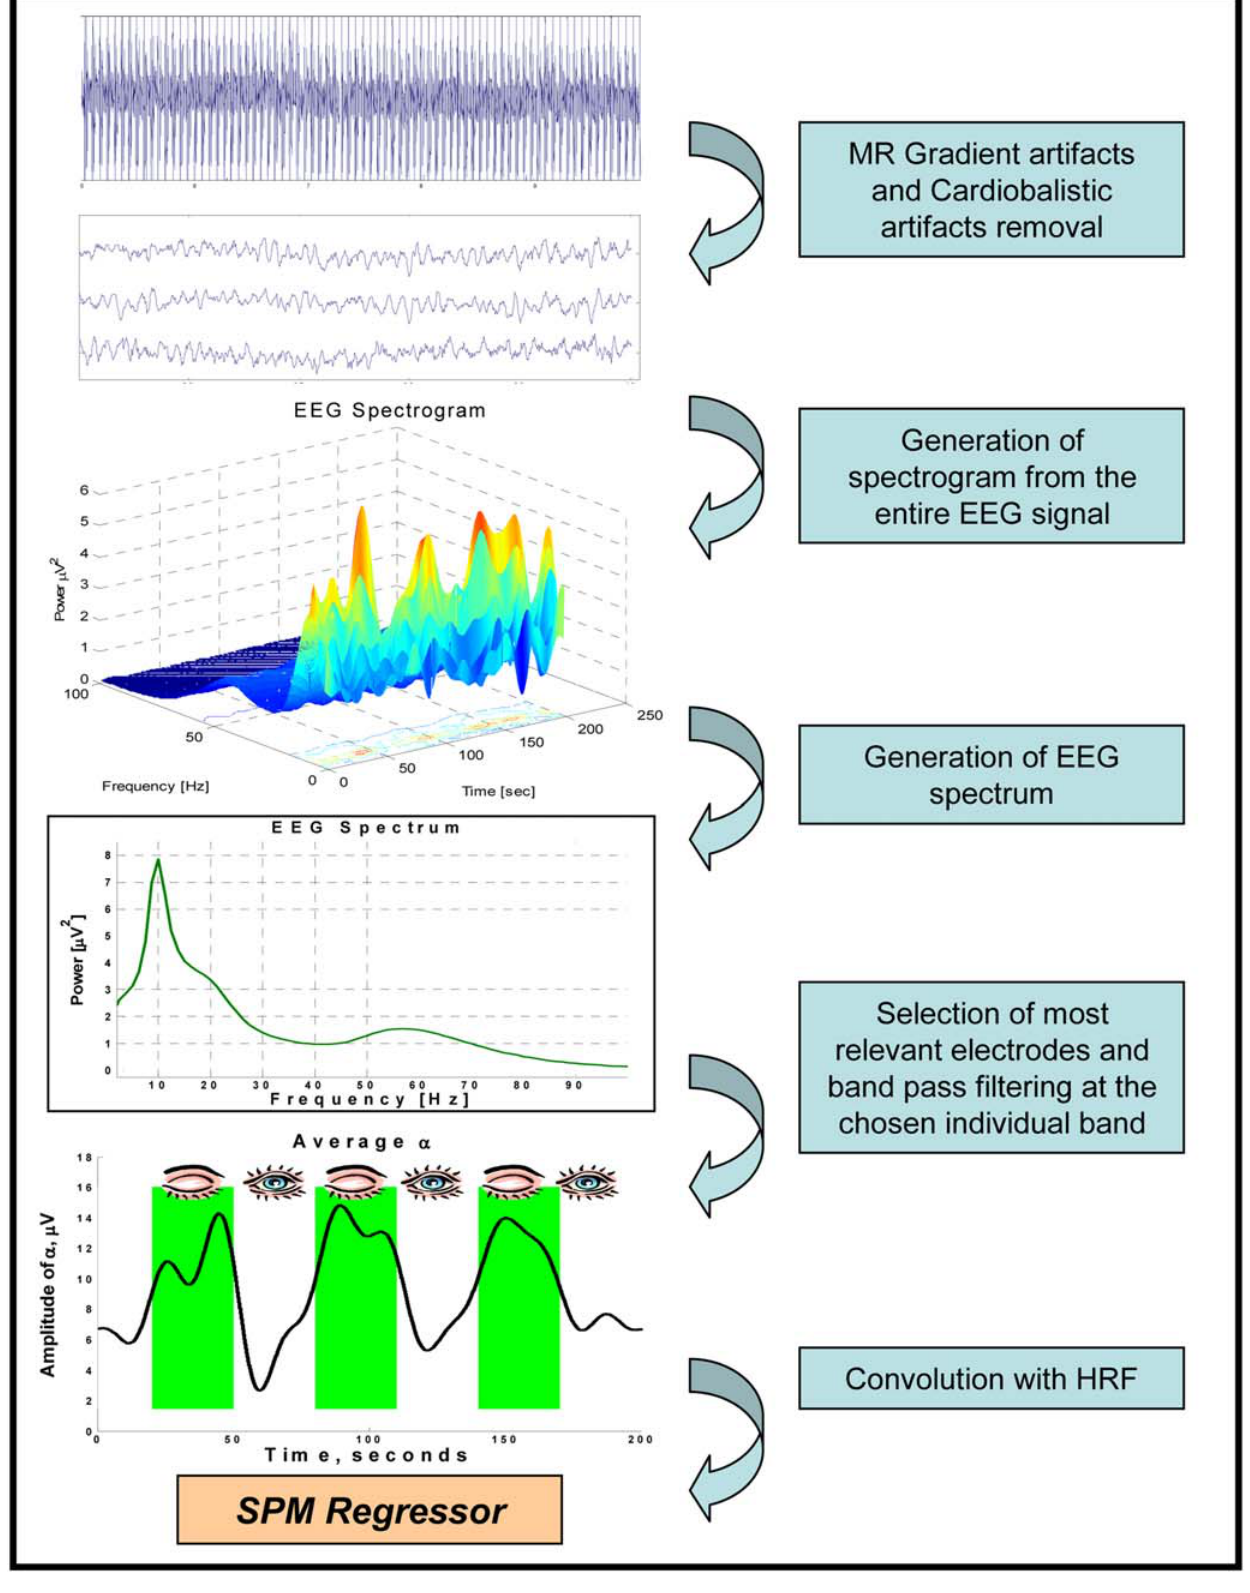
Figure 2. EEG analysis steps. 1. Gradient and cardioballistic artifact removal performed on raw EEG data; 2. Generation of spectrogram from the entire EEG signal; 3. Generation of EEG spectrum by averaging the spectrogram across the time of the experiment (200 sec); 4a. Selection of five electrodes with the highest alpha peak and selection of subject specific alpha band from the EEG spectrum; 4b. Calculation of instantaneous alpha amplitude throughout the experiment, at the chosen electrodes by means of band pass filtering at the chosen band and Hillbert transform; 5. Calculation of a regressor for fMRI analysis by convolution of the instantaneous alpha amplitude with HRF. doi:10.1371/journal.pone.0003984.g002 PLoS ONE |